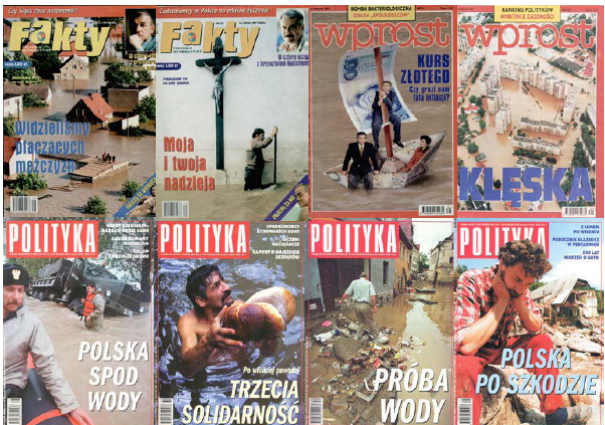
Figure 1. In summer 1997, many cover stories of weekly magazines in Poland referred to the dramatic July floods and illustrated various aspects of human